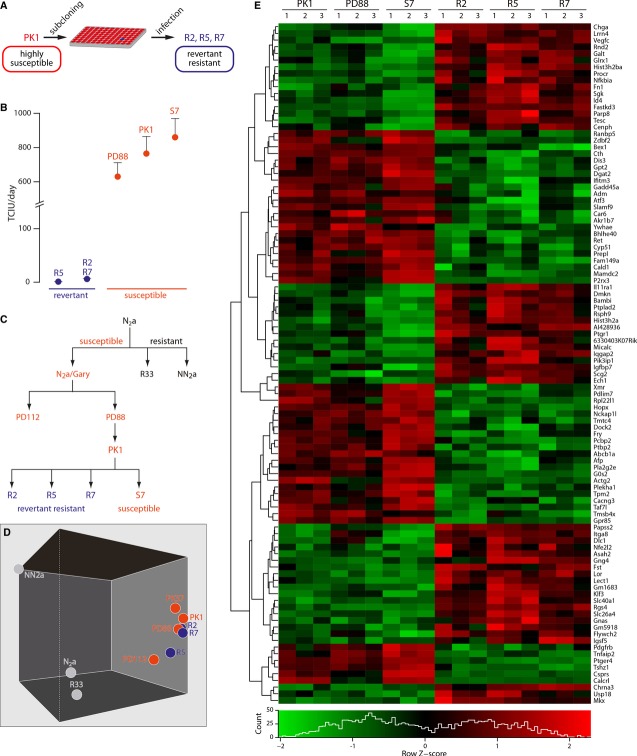
Characterisation of cognate prion-resistant revertants derived from highly susceptible cellsSchematic for the isolation of prion-resistant revertants.Susceptible cells (S7, PK1, PD88) propagate prions 2–3 orders of magnitude faster than revertants. Prion propagation rates of cells infected with mouse RML prions are expressed as tissue culture infectious units (TCIU)/day.Lineage of susceptible and resistant cell clones isolated from parental N2a cells (grey: resistant, red: susceptible, blue: revertant resistant).Gene expression profiles of N2a cell clones were mapped onto a 3D transcript profile space after reducing dimensionality to three principal components. PK1-derived susceptible and revertant clones cluster around PK1 cells.Hierarchical clustering of genes differentially expressed between prion-resistant revertants and susceptible cells. Genes with a fold discovery rate (FDR) < 0.01 and a fold difference of at least two were included. Right legend: gene names, columns: samples of three biological repeats. Colour intensities based on expression level of genes as specified by the bar code on the bottom. Green: low-intensity values, red: high-intensity values, black: no change. Dendrogram cluster analysis on the left side.